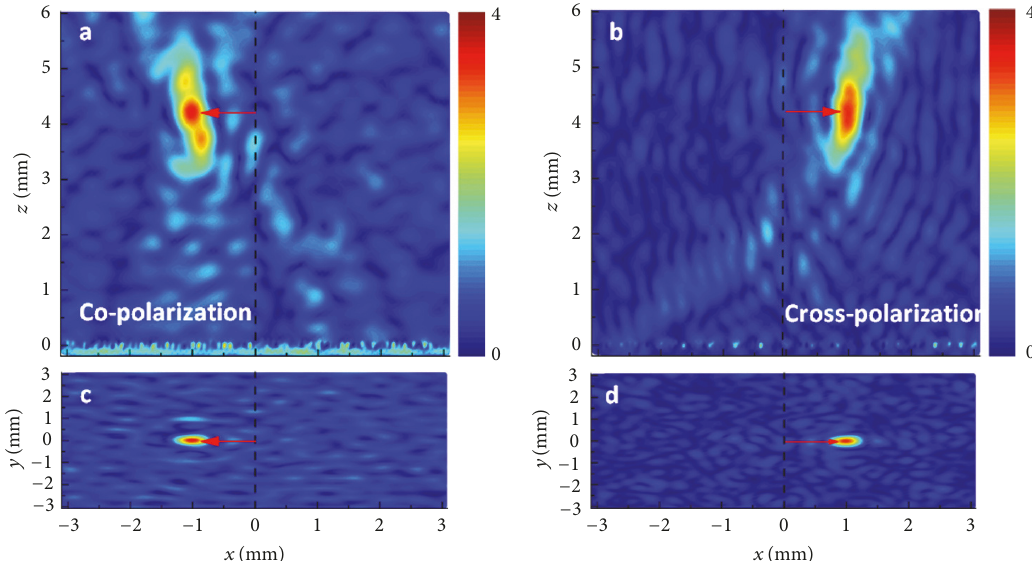
Figure 6: (a, b) The copolarized and cross-polarized electric field intensity of the transmitted waves in the 𝑥 - 𝑜 - 𝑧 plane at 0.68 THz, respectively. (c, d) The copolarized and cross-polarized electric field intensity of the transmitted waves in the 𝑥 - 𝑜 - 𝑦 plane at 𝑍 = 4.23 mm.